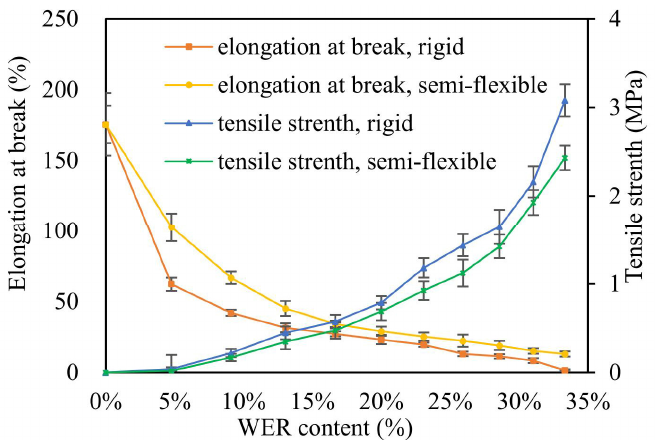
Figure 14. Tensile test result.